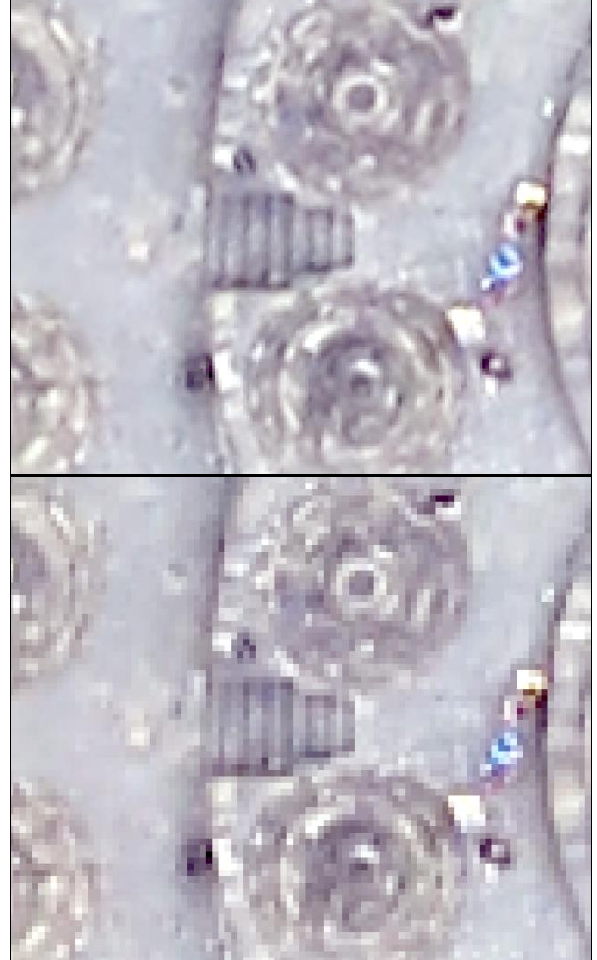
Figure 9. Comparison between 5 cm (upper) and 10 cm (lower)